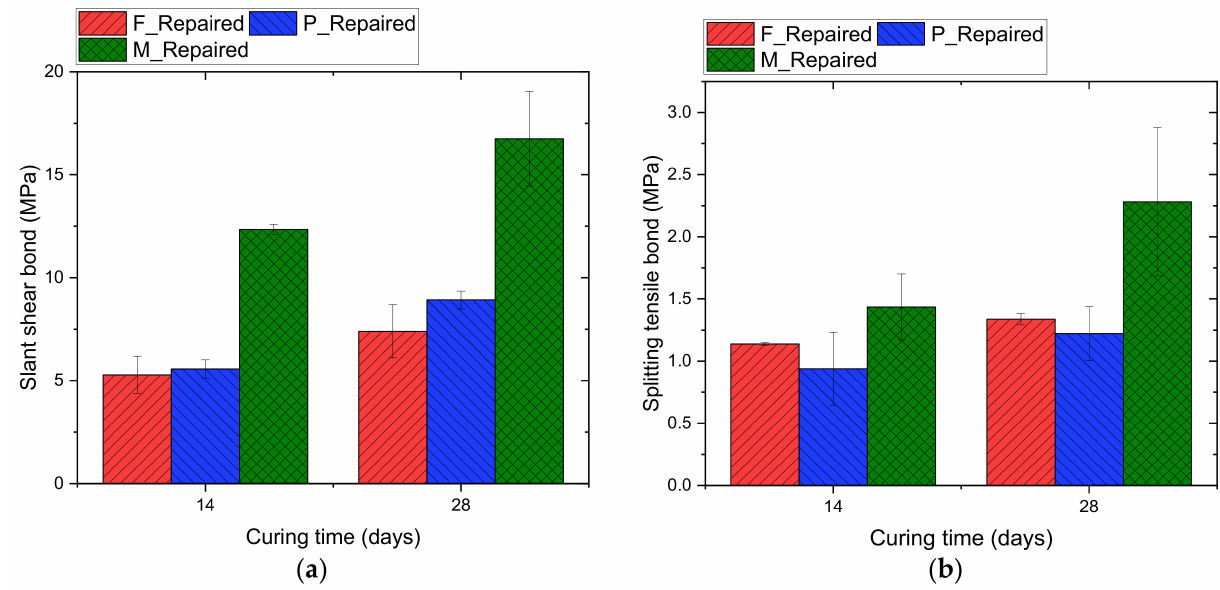
Figure 7. Bond stresses at failure for different repair materials ( a ) slant shear bond ( b ) Splitting tensile